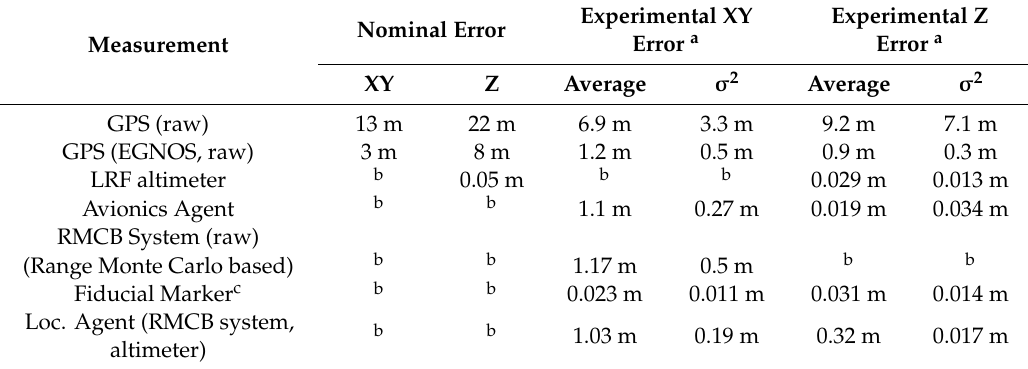
Experimental XY Experimental Z Nominal Error Error a Error